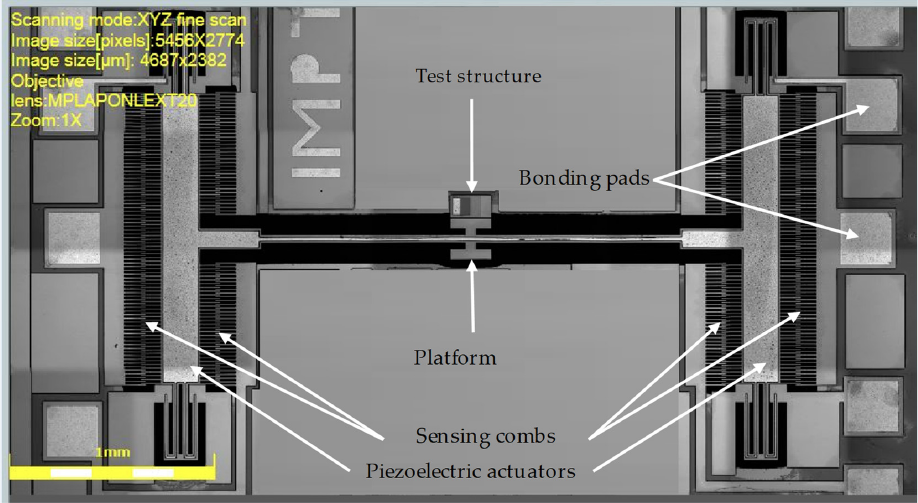
Figure 3. Optical micrograph of the fabricated MEMS